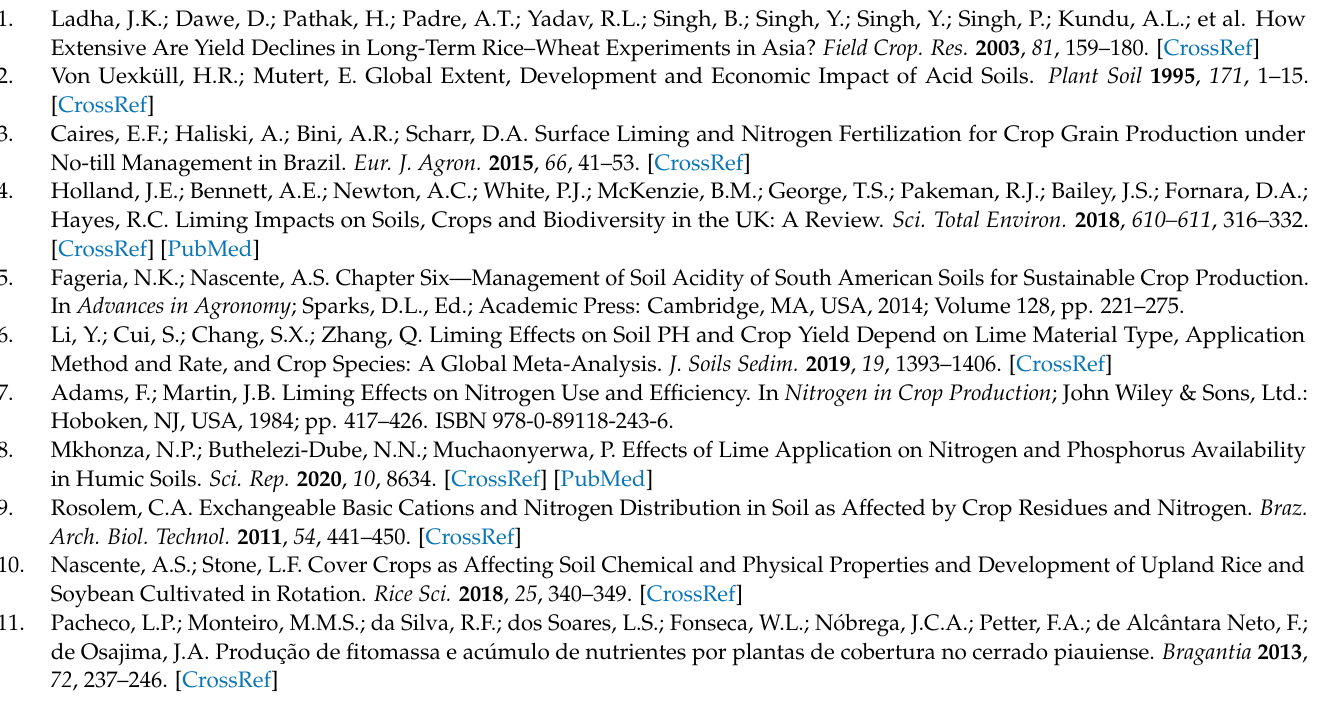
Figure S4. Total dry matter and total N accumulated in upland rice under different treatments (0 (no Table S1. Means of maximum and minimum temperatures and rainfall during the experiment period; Table S2. Statistical parameters by ANOVA test at p ≤ 0.05 significance level of experimental factors (N rates × lime application) for maize nutrition and agronomic parameters; Table S3. Statistical parameters by ANOVA test at p ≤ 0.05 significance level of experimental factors (N rates × lime application) for upland rice nutrition and agronomic